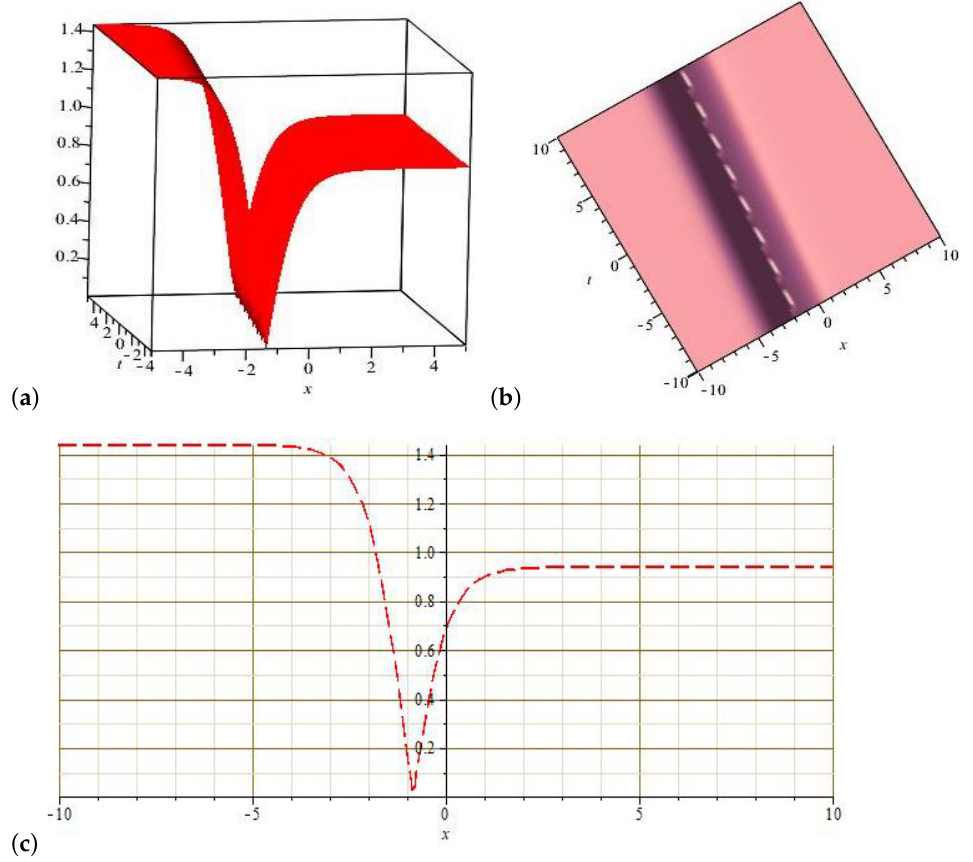
Figure 2. Graphical view of | Q 11 ( (cid:36) ) | for A 1 = 1.5, c 1 = 0.61, c 0 = − 0.79, A 0 = 0.25, (cid:36) 0 = 1.06, c 2 = 1.26 and (cid:101) = 0.1: ( a ) 3D plot, ( b ) contour plot, and ( c ) 2D plot at t = 0.